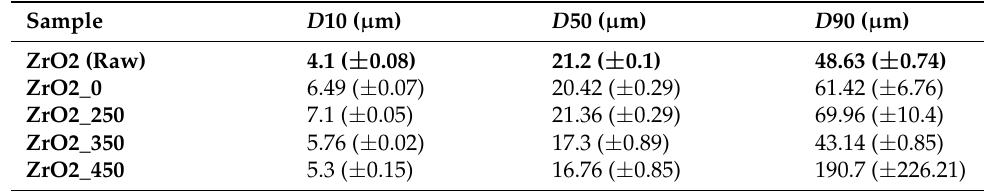
Table 3. PSD of the APTES-modified ZrO 2 powders.